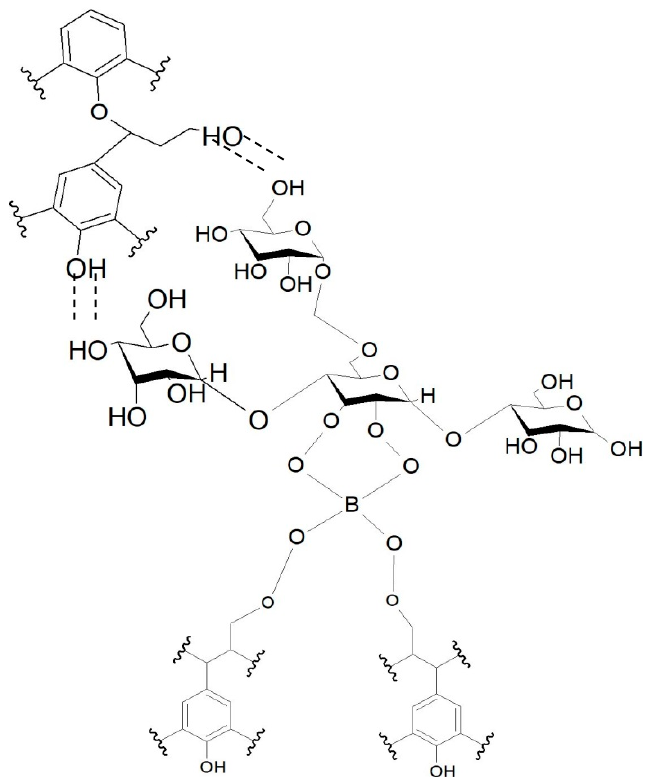
Figure 5. Possible cross-linking and hydrogen bonding between starch and lignin molecules.